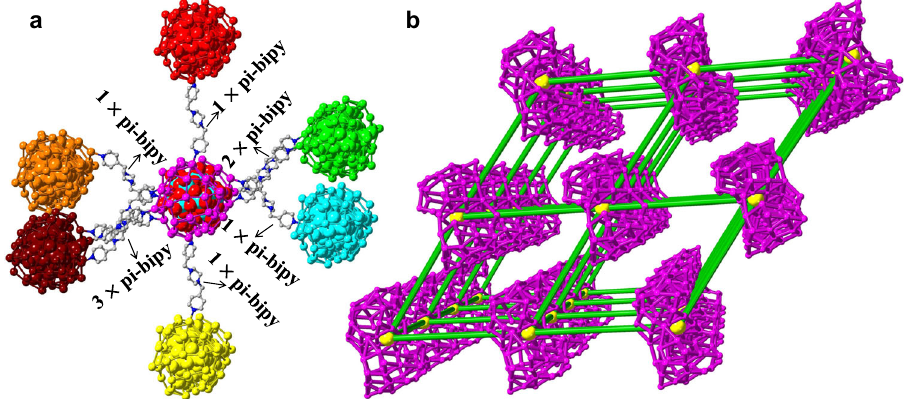
Fig. 6 Crystal structure of SD/Ag72c. a The connections between [(PW 9 O 34 ) 2 @Ag 72 ] clusters in SD/Ag72c . PW 9 O 34 9 − is shown in space- fi lling mode.